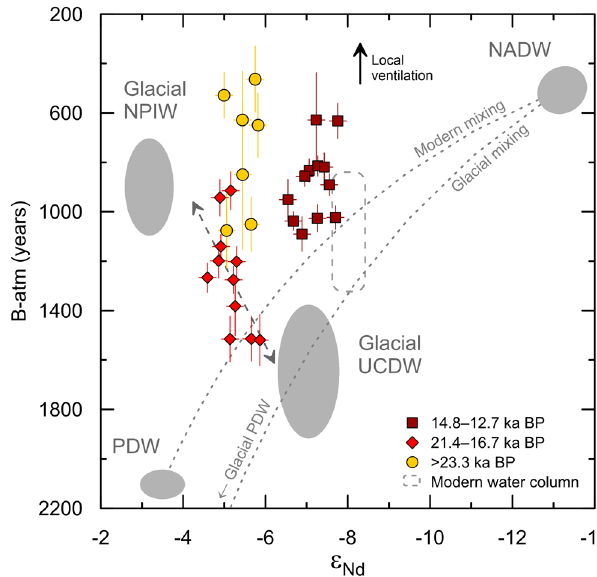
Fig. 4 Tasman cold-water coral data in radiocarbon – Nd isotope ( ε Nd ) space. The benthic-atmosphere radiocarbon ( 14 C) age offsets (B-atm) were calculated using an atmospheric 14 C age of 0 years (1950 AD) for the modern seawater values 2,102 . For past B-atm, we used coral 14 C ages 44 and IntCal20 atmospheric 14 C ages 102 . Atmospheric 14 C values were calculated as averages of the reported 1s coral calendar age uncertainty range 44 . Error bars represent 1s propagated uncertainties for B-atm age offsets and 2SD uncertainties for ε Nd . Modern water column data comprise regional Antarctic Intermediate Water (AAIW), Upper Circumpolar Deep Water (UCDW), and Lower Circumpolar Deep Water (LCDW) properties 2,40 . Hypothetical mixing calculations (dotted lines) use the following endmembers: modern North Atlantic Deep Water (NADW, ε Nd = − 13.2, [Nd] = 17.6pmol/kg, B- atm = 500 years, DIC [dissolved inorganic carbon] = 2160 μ mol/kg) 2,36 ; modern Paci fi c Deep Water (PDW, ε Nd = − 3.5, [Nd] = 44.4pmol/kg, B- atm = 2100 years, DIC = 2350 μ mol/kg) 2,37 . Note that these hypothetical mixing lines do not account for non-conservative processes along the water mass fl ow paths. Glacial PDW was de fi ned using an LGM B-atm age offset of 3000 years 64 and otherwise modern PDW parameters due to the similarity of glacial and modern PDW Nd isotope compositions 54,71,72 . Glacial UCDW was estimated based on the Drake Passage coral Nd isotope 30,34 and radiocarbon data 31,69,103 . Glacial North Paci fi c Intermediate Water (NPIW) properties at its source are estimated based on modern Nd isotope compositions 37,38 and LGM radiocarbon ages 35 . A dashed gray arrow indicates mixing between glacial UCDW and glacial NPIW. Local ventilation (e.g., via deepening of Southern Ocean AAIW) would lead to lower B-atm and relatively invariant ε Nd values (black arrow). Where paired radiocarbon – Nd isotope data were not available from the same coral specimen, we matched the Nd isotope data with radiocarbon data from nearby corals of the same age (i.e., within age uncertainty and with <100 m depth